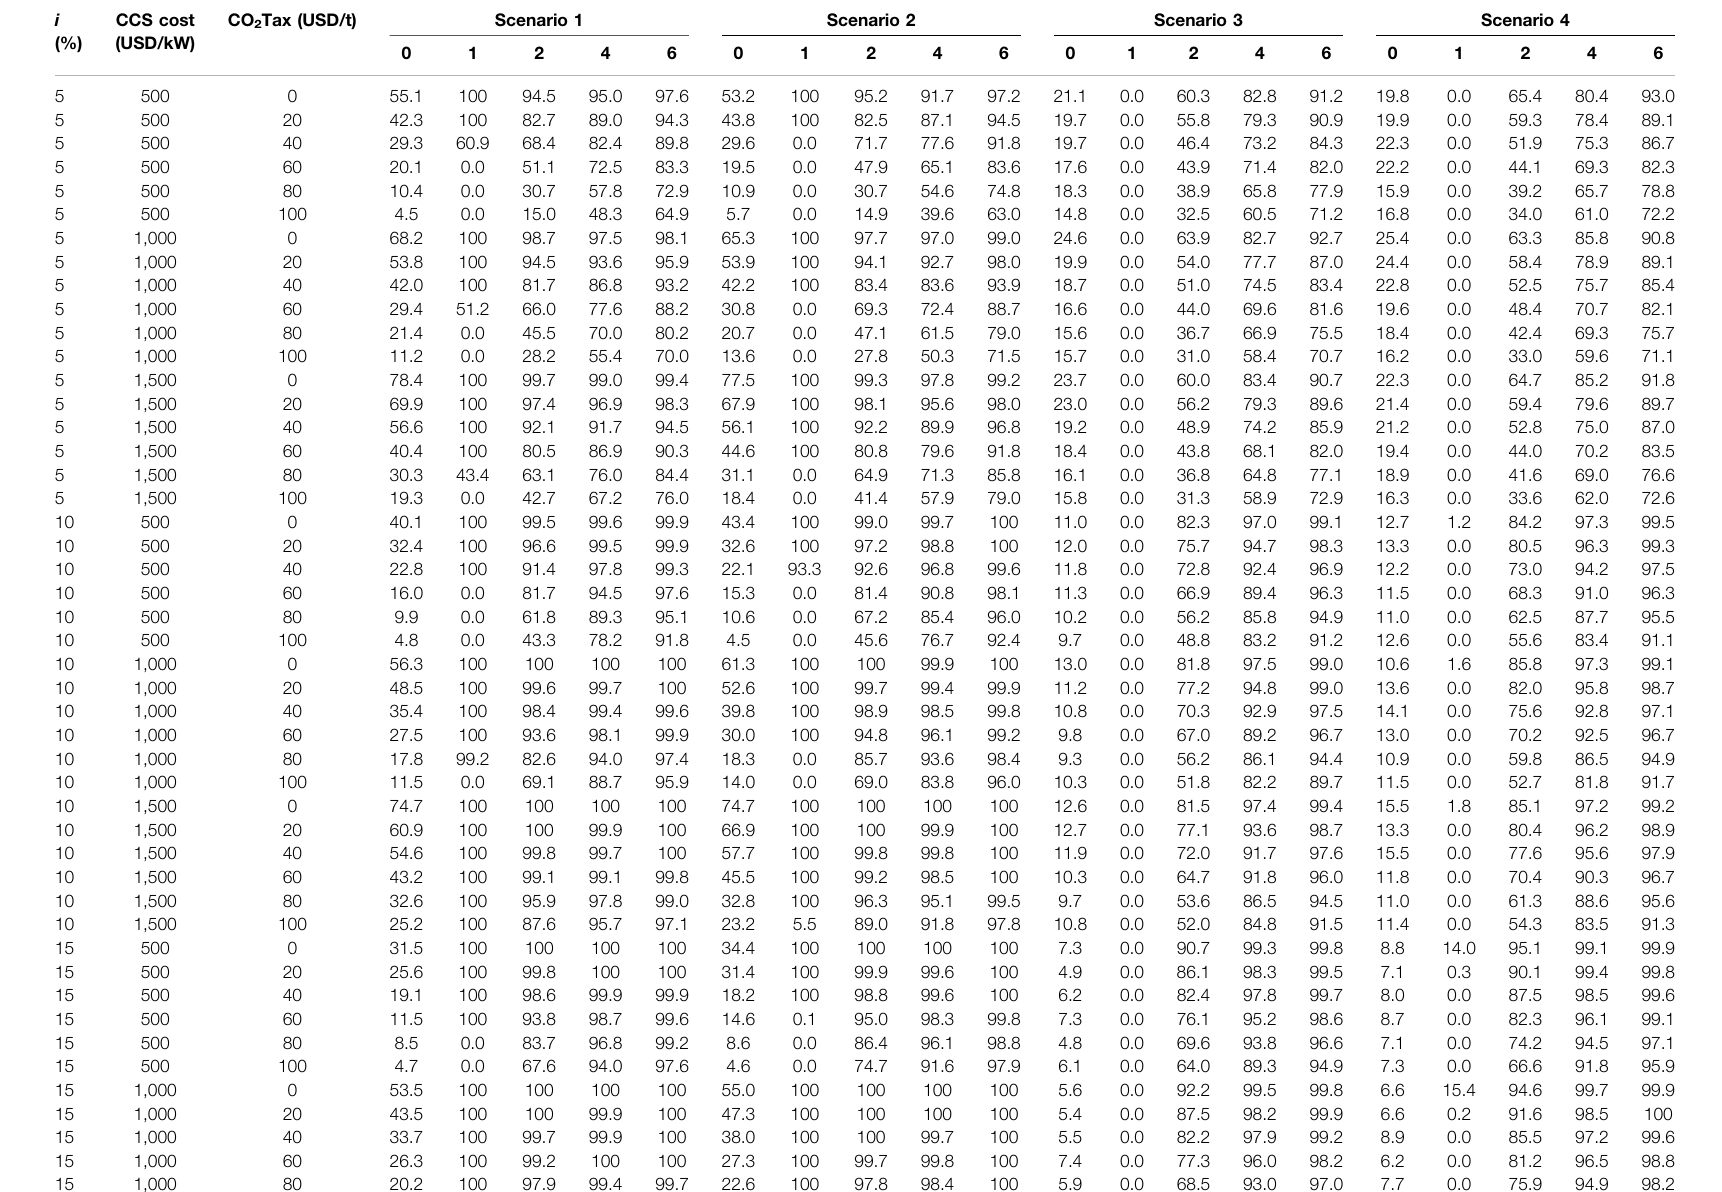
TABLE 5 | Likelihood of loss (%) as a function of the delay in entrance of operation, the interest rate, the speci fi c CCS unit cost and the CO 2 tax. i CCS cost (%)